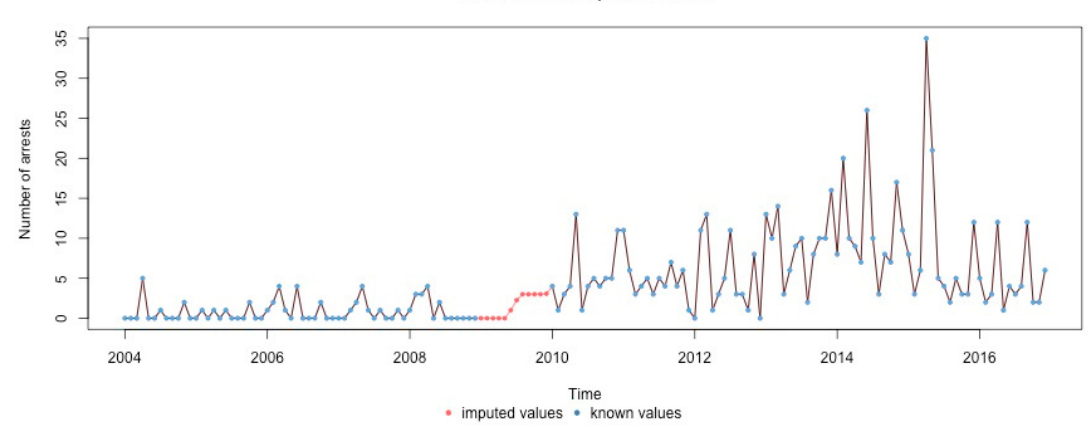
Figure A3. Methamphetamine foreign nationals arrests 2004–2016 in the Czech Republic – imputed missing values.